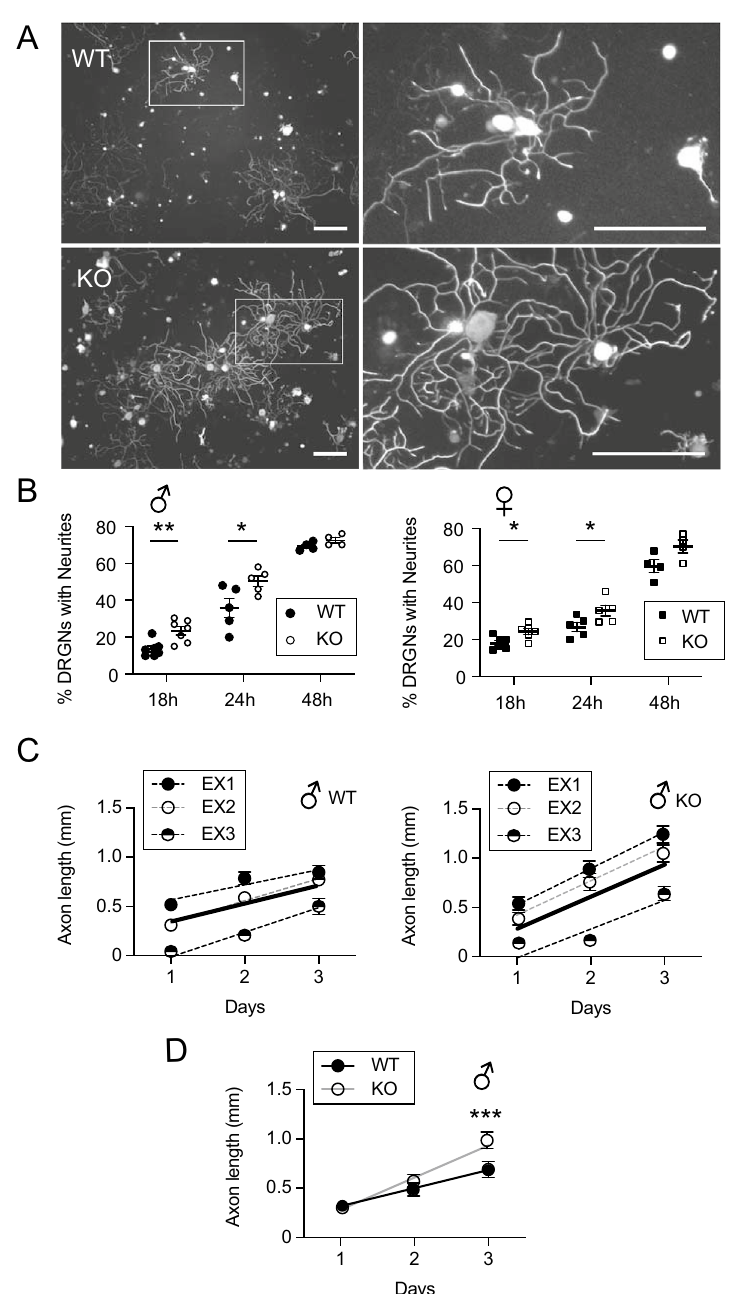
Figure 5. Caldendrin inhibits the regeneration and rate of outgrowth of DRGN neurites. DRGNs from WT and caldendrin KO mice were cultured for various periods prior to immunolabeling with NF200 antibodies. ( A ) Representative confocal images of WT and caldendrin KO DRGNs (24 h in culture). Boxed region in left panels is shown at higher magnification in right panels. Scale bars, 200 µm. ( B ) Percent of DRGNs with neurites in cultures from males (left) and females (right) at the indicated times in culture. Each point represents the average obtained from a single culture (n = 300–400 DRGNs/culture), bars represent mean ± SEM. For male data: **t(12) = 3.584, p = 0.004; *t(8) = 2.447, p = 0.04. For female data: *t(10) = 2.916, p = 0.015; *t(8) = 2.262, p = 0.05, compared to WT by unpaired t-test. ( C , D ) Neurite growth measured in DRG explants. DRGs were cultured from WT/PirtGCaMP3 (left) and caldendrin KO/PirtGCaMP3 (right) male mice (at least 2 DRGs per mouse, n = 3 mice, results from each mouse are represented in different symbols). Lengths of the same neurites were measured each day for 3 days. Dashed and smooth lines represent linear fits from individual explants and the averaged data, respectively. Symbols and bars represent mean ± SEM. Data from C are replotted in D to indicate significant increase in neurite length in caldendrin KO explants on day 3. *** p = 0.0006, determined by Kolmogorov–Smirnov